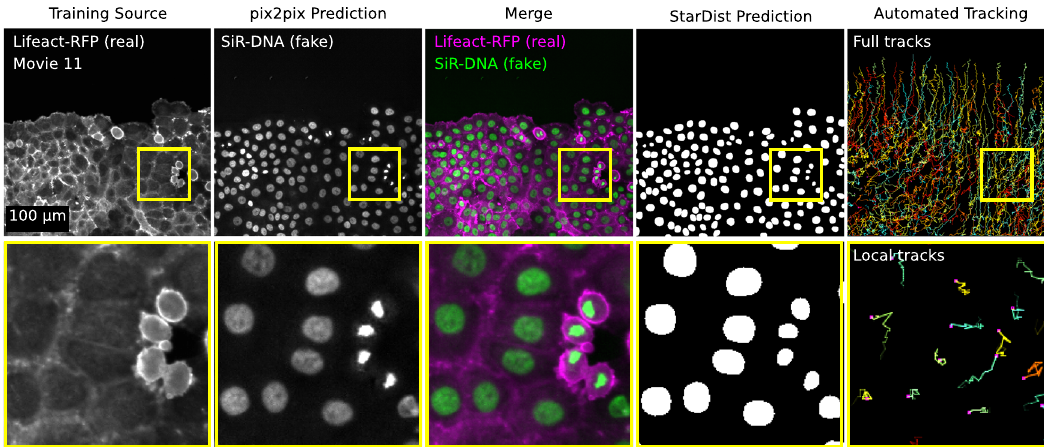
Fig. 7 Example illustrating how ZeroCostDL4Mic notebook can be used together. Figure highlighting how ZeroCostDL4Mic notebooks can be combined to create a data analysis pipeline. Here, we wanted to automatically track the migration pattern of DCIS.COM cells labelled with lifeact-RFP. Therefore, we fi rst used pix2pix to predict the actin staining into nuclei staining (as in Fig. 6c) and StarDist to detect the nuclei. From the StarDist prediction, cells were tracked automatically using TrackMate 38 (as in Fig. 2d; see also Supplementary Movie 11). A representative fi eld-of-view is